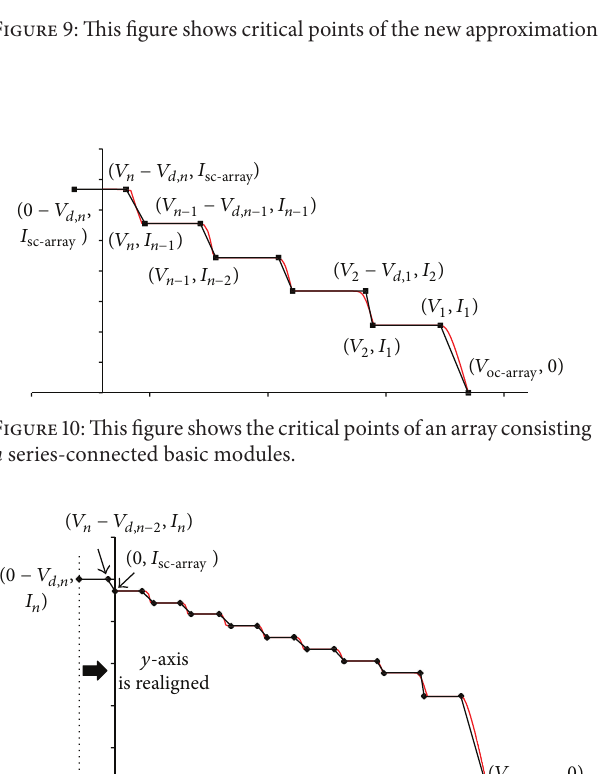
is updated as a sc-array